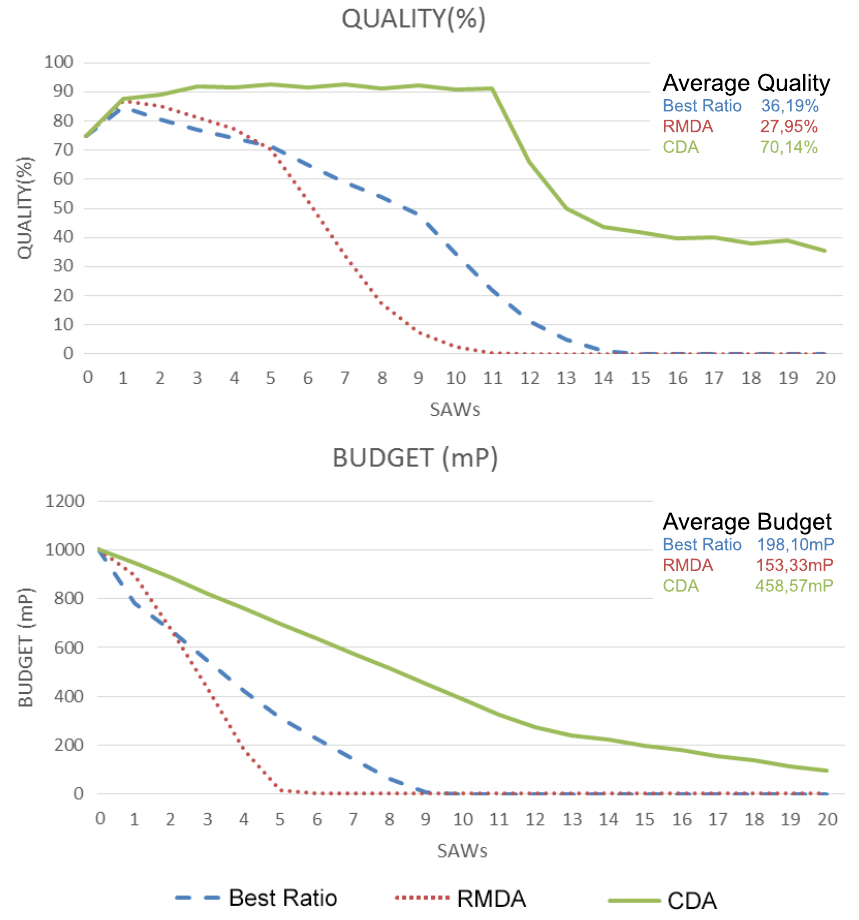
Figure 5. Auction-based comparison results under medium budget